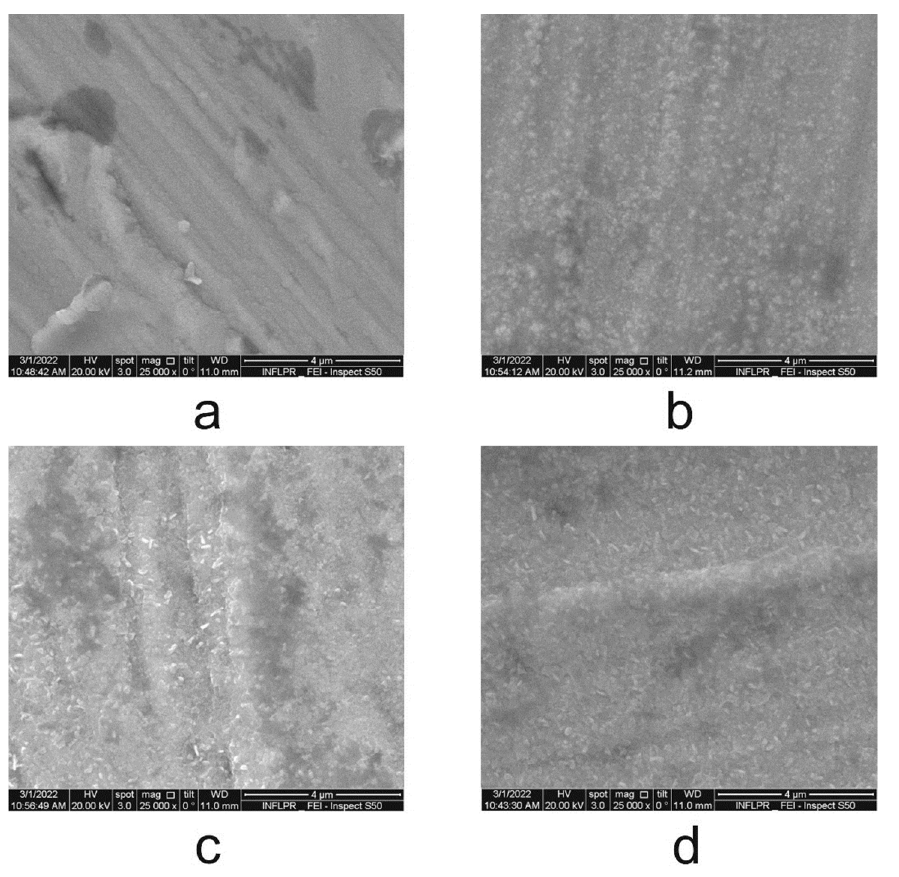
Figure 5. The surface morphologies of coated 310 H SS samples before and after different periods of exposure in water at 550 ◦ C and 25 MPa at a magnification of 10,000 × : ( a ) 0 h, ( b ) 720 h, ( c ) 1440 h, ( d ) 2160 h. Inset EDS analysis.